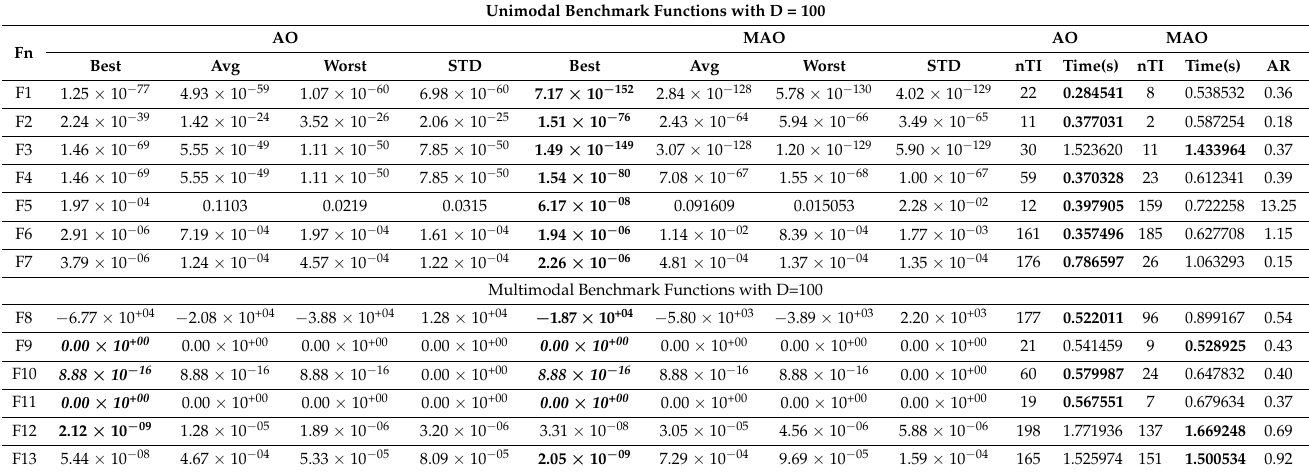
Table 7. Results obtained for unimodal and multimodal functions with D = 100.